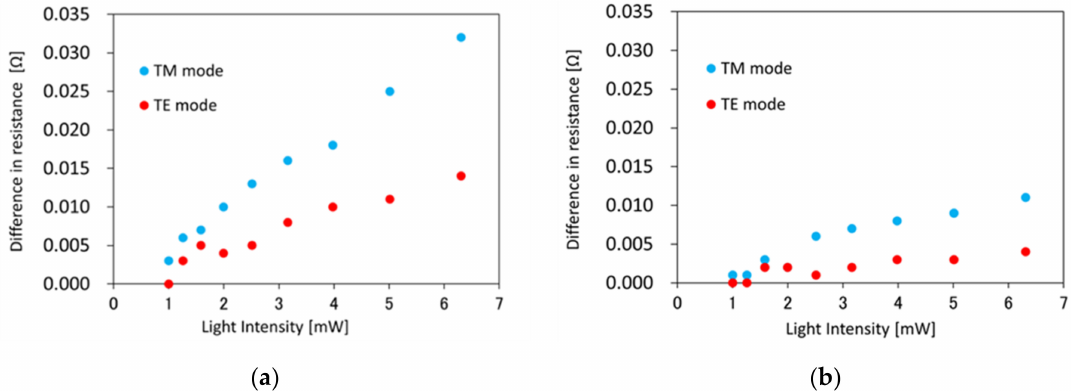
Figure 5. Difference in resistance ∆ R light of the Co layer with the Si waveguides having the waveguide width w of ( a ) 400, and ( b ) 1000 nm, upon TM and TE mode light injection at steady state.